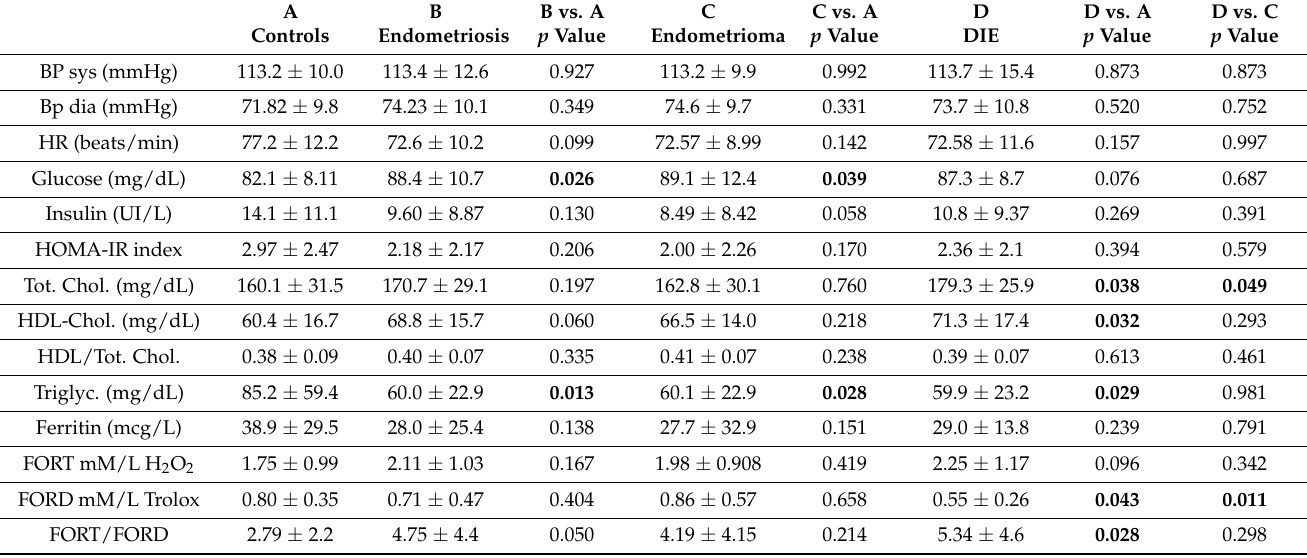
Table 2. Mean and standard deviation (mean ± SD) of general health characteristics and blood test results observed in controls ( n = 24) and cases ( n = 52) considered together or divided by type of endometriosis, i.e., either endometrioma alone ( n = 26) or deep pelvic infiltrating endometriosis (DIE) with or without endometrioma ( n = 26). Significance of the between-group comparisons is reported. A B B vs. A p Controls Endometriosis